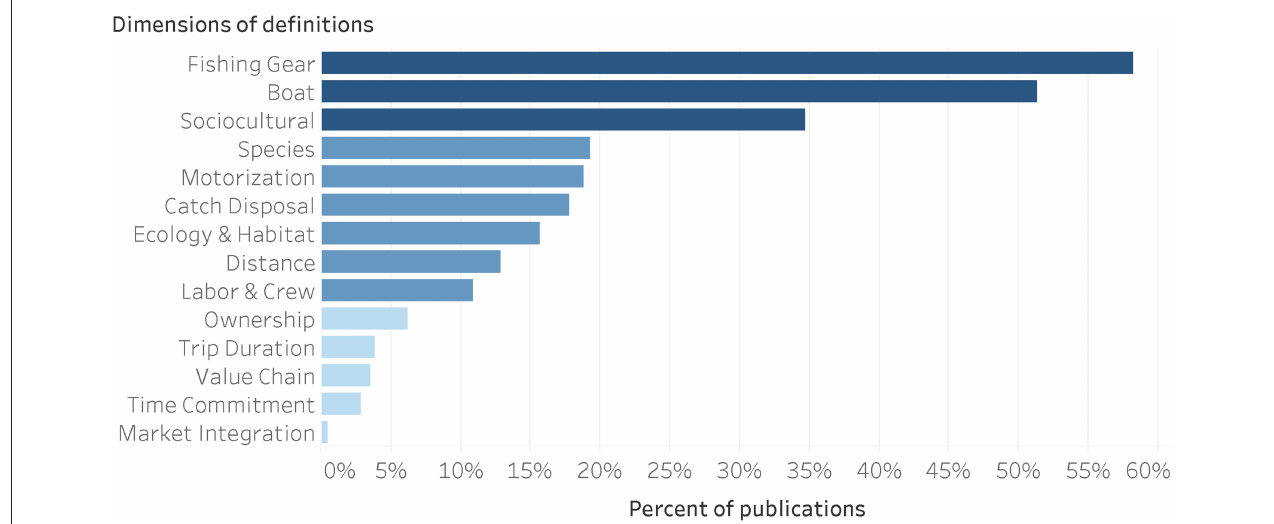
FIGURE 4 | The percentage of publications that used different characteristics to define SSF. The blue shading indicates three natural groupings that emerged from the data based on the frequency of use: commonly used characteristics (35% or more), moderately used characteristics (10–20%), and those infrequently used (occurring in < 10% of